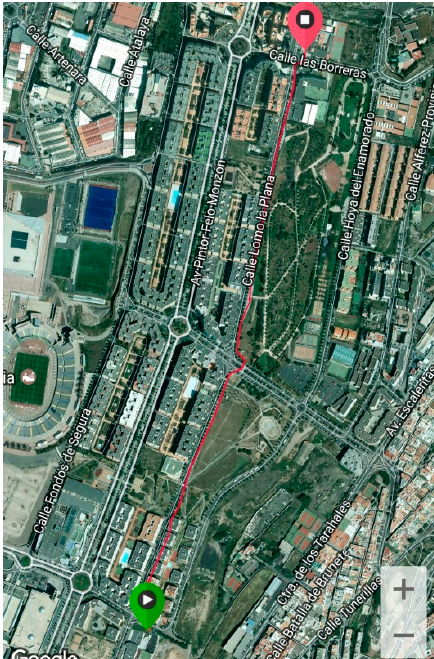
Figure 24. Satellite view of the route.